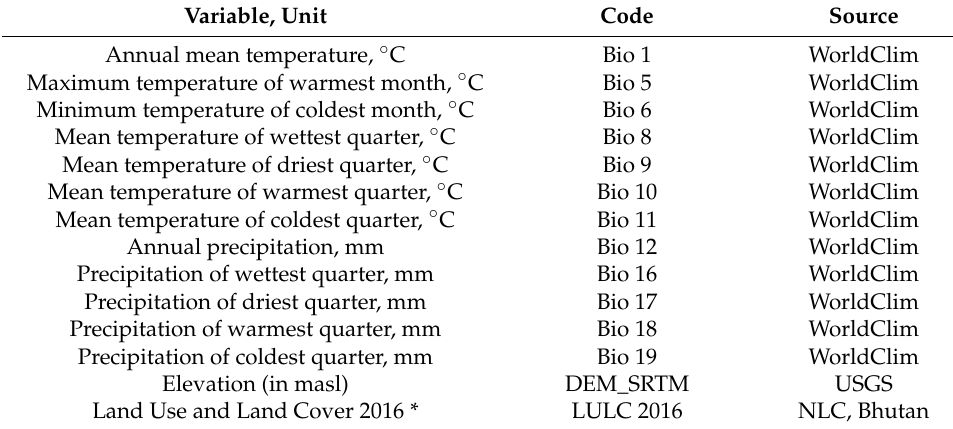
Table 2. Environmental variables used in building MaxEnt habitat suitability models. Variable,